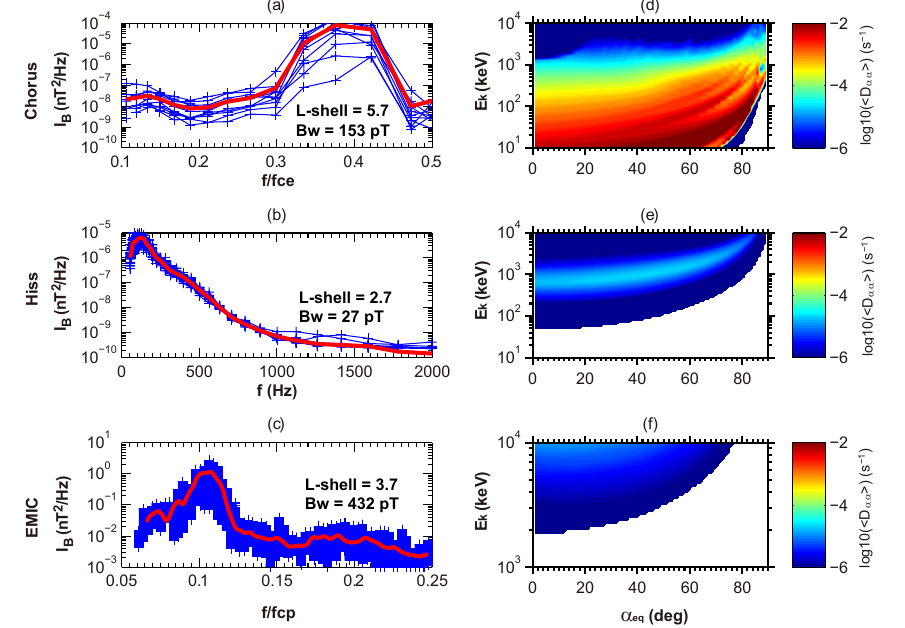
Figure 11. Line plots of magnetic field spectral intensity for (a) chorus, (b) plasmaspheric hiss, and (c) He + -band EMIC waves corresponding to the representative periods marked in Fig. 9, together with the mean profiles shown as thick red curves. Two-dimensional plots of bounce- averaged pitch angle scattering rates < D αα > as a function of electron kinetic energy E k and equatorial pitch angle due to (d) chorus, (e) plasmaspheric hiss, and (f) He + -band EMIC